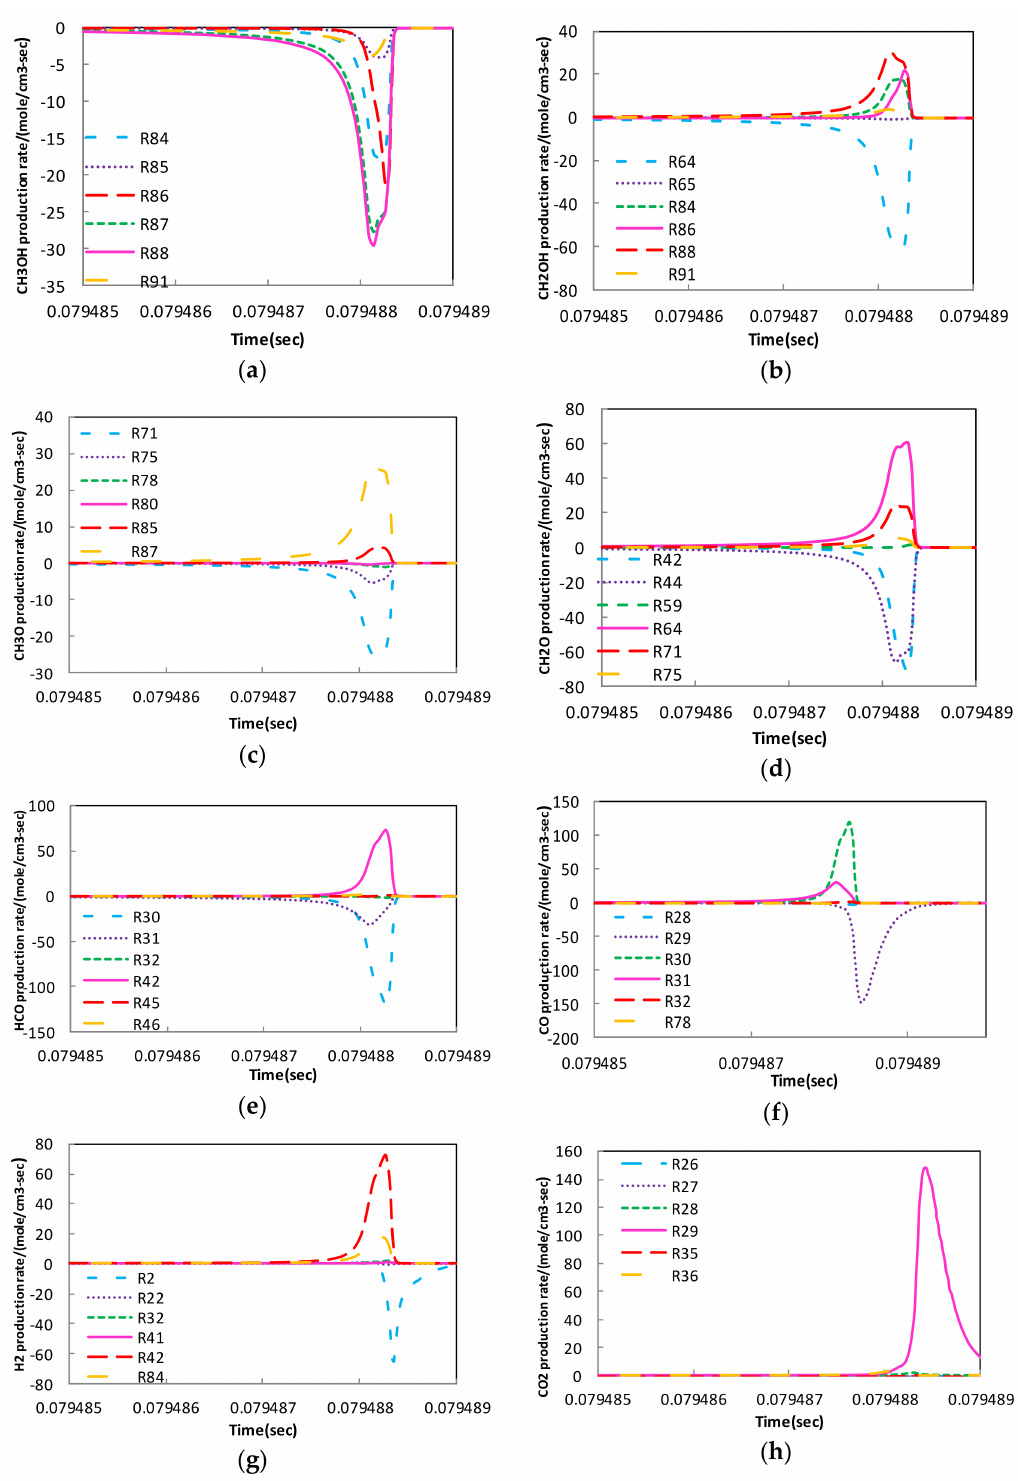
Figure 7. Production rate analysis of methanol. ( a ) CH 3 OH production rate; ( b ) CH 2 OH production rate; ( c ) CH 3 O production rate; ( d ) CH 2 Oproduction rate; ( e ) HCO production rate; ( f ) CO production rate; ( g ) H 2 production rate; ( h ) CO 2 production